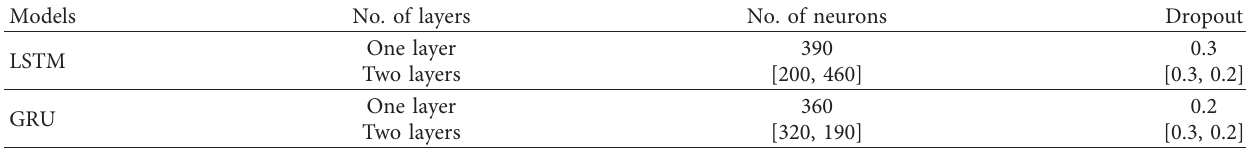
Table 2: The best value parameters of DL for confirmed cases in Egypt.